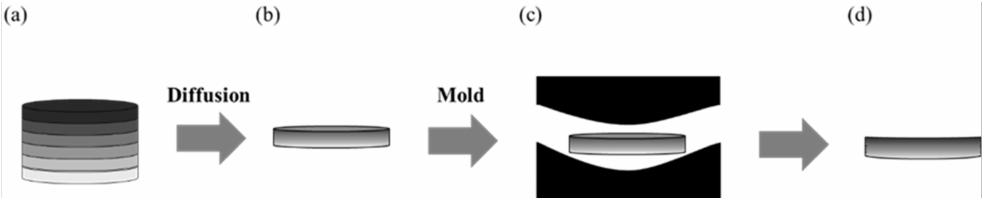
Figure 1. Schematic of the glass accumulation thermal diffusion method and molding. ( a ) Glass stack from the high refractive index ( top ) to low refractive index ( bottom ); ( b ) glass stack after thermal diffusion. The gradient of color indicates the distribution of refractive index. ( c ) Molding of GRIN lens into a spherical GRIN lens; ( d ) hot-pressed